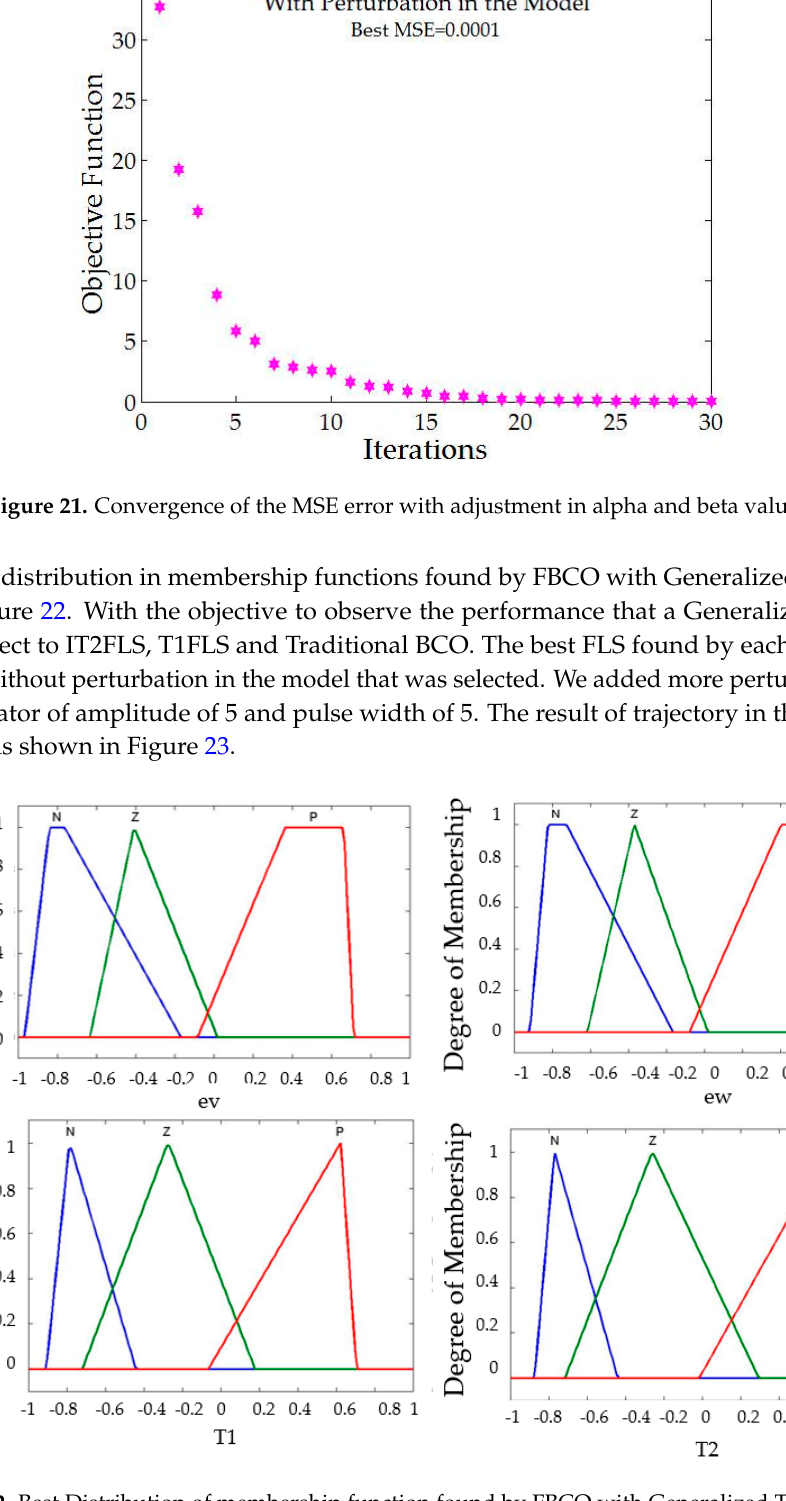
Figure 22. Best Distribution of membership function found by FBCO with Generalized Type-2 FLS.